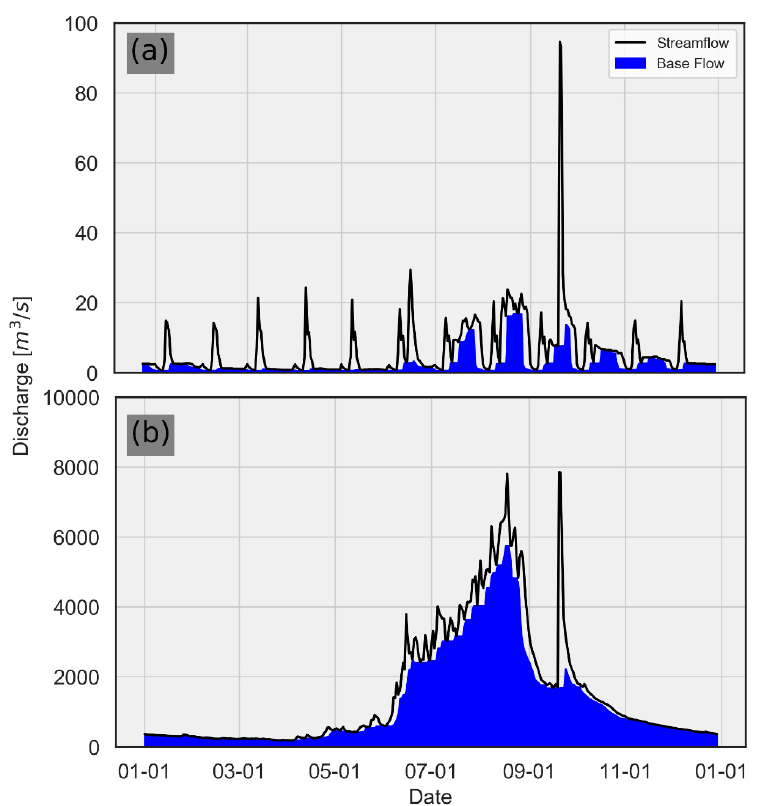
Figure A2. Demonstration of streamflow separation using HYSEP. Area highlighted in the blue represents the baseflow while the remaining area represents the direct run-off component. ( a , b ) correspond to the Langurkhola in Chhana (159 km 2 ) and Karnali river in Chisapani (42,890 km 2 ), respectively.